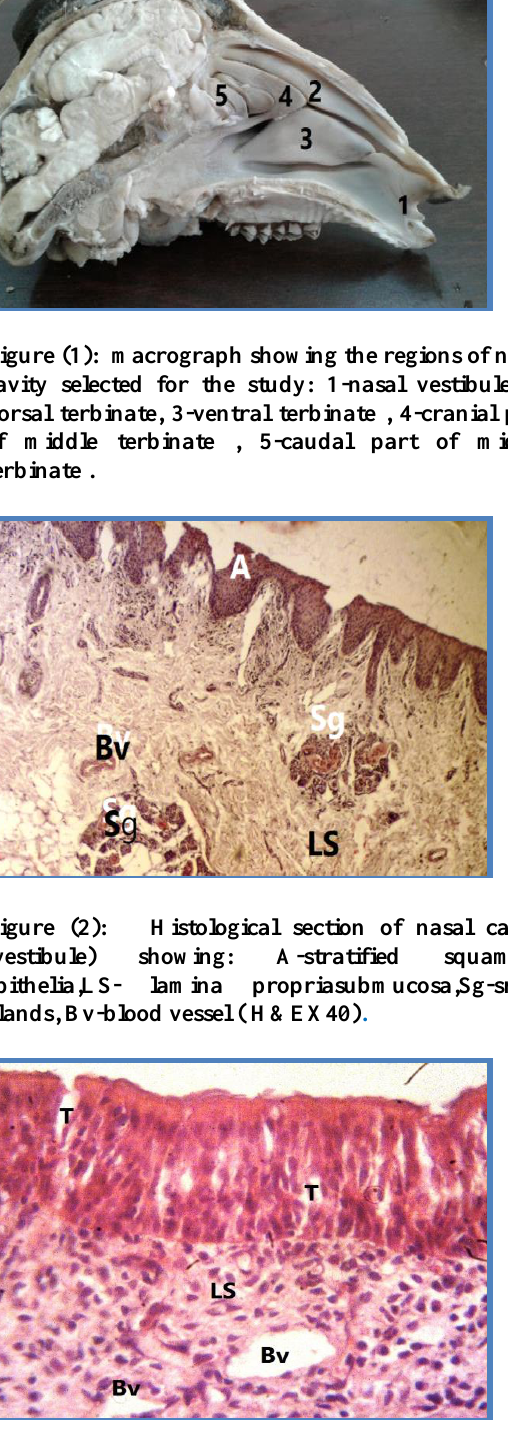
Figure (3): Histological section of nasal cavity (vestibule) showing: A-stratified columnar epithelia (transitional) , LS- lamina propriasubmucosa, BV- blood vessls, T-transmission area (H&EX